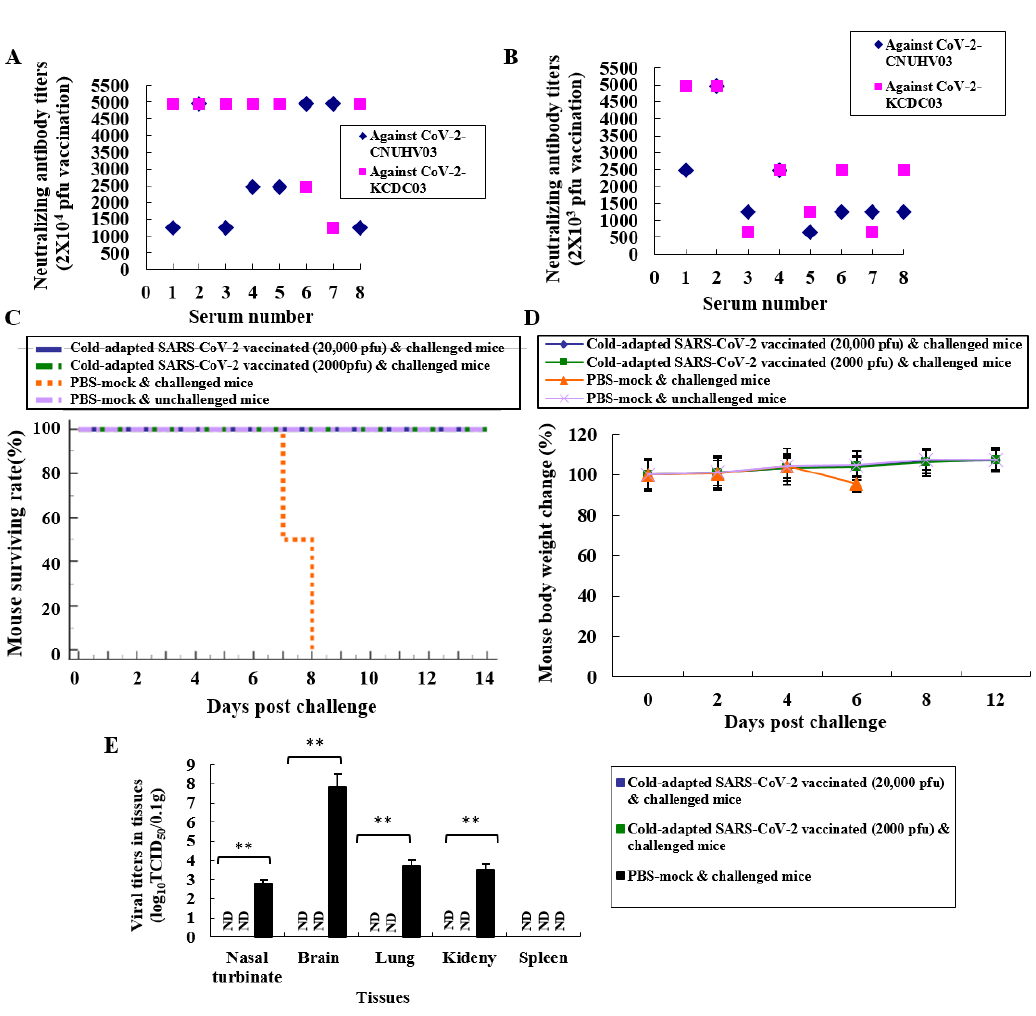
Figure 3. Neutralizing antibodies and challenge of immunized hACE2 transgenic mice with cold-adapted SARS-CoV-2 vaccine strain. Sera collected from K18-ACE2 mice ( n = 8 per group) immunized with 2 × 10 4 pfu or 2 × 10 3 pfu of cold adapted SARS-CoV-2 (CoV-2-CNUHV03-CA22 ◦ C) 19 days ago, and their neutralizing antibody titers were determined against wild-type SARS-CoV-2 viruses, CoV-2-CNUHV03 and CoV-2-KCDC03 in Vero cells. ( A ) Sera from immunized mice with 2 × 10 4 pfu of CoV-2-CNUHV03-CA22 ◦ C; ( B ) Sera from immunized mice with 2 × 10 3 pfu of CoV-2-CNUHV03-CA22 ◦ C. Sera ( n = 16) collected before immunization were used as a control. Detection limit of neutralizing antibody is 10. * p < 0.05, ** p < 0.001. K18-ACE2 mice ( n = 8 per group) immunized with 2 × 10 4 pfu or 2 × 10 3 pfu of cold adapted SARS-CoV-2 (CoV-2-CNUHV03-CA22 ◦ C) 21 days ago were i.n. challenged with 2 × 10 4 pfu of wild-type SARS-CoV-2 (CoV-2-KCDC03). PBS-mock vaccinated mice ( n = 6) were also i.n. challenged with 2 × 10 4 pfu of CoV-2-KCDC03 and PBS-mock and unchallenged mice ( n = 3) were used as a control. The challenged mice were monitored for mortality and change in body weight for 12 days. On day 6 post challenge, the challenged mice ( n = 3) were euthanized for viral titers in tissues. One PBS-mock and unchallenged mouse was euthanized on day 6. ( C ) Mice mortality rate (%); ( D ) the change of mouse body weights (%) compared to those before challenge, ( E ), viral titers in mouse tissues ( n = 3 per group) of nasal turbinate, brain, lung, kidney, and spleen by log 10 TCID 50 / 0.1g. Viral titers are the mean of 3 tissues ± standard deviations. Detection limit of virus is 1 TCID 50 / 0.1g.* p < 0.05, ** p < 0.001, ND: non-detected. K18-hACE2 mice were i.n. immunised with 2 × 10 4 or 2 × 10 3 pfu of CoV-2-CNUHV03-CA22 and i.n. challenged with 2 × 10 4 pfu of CoV-2-KCDC03 on 21 days p.v. The challenged